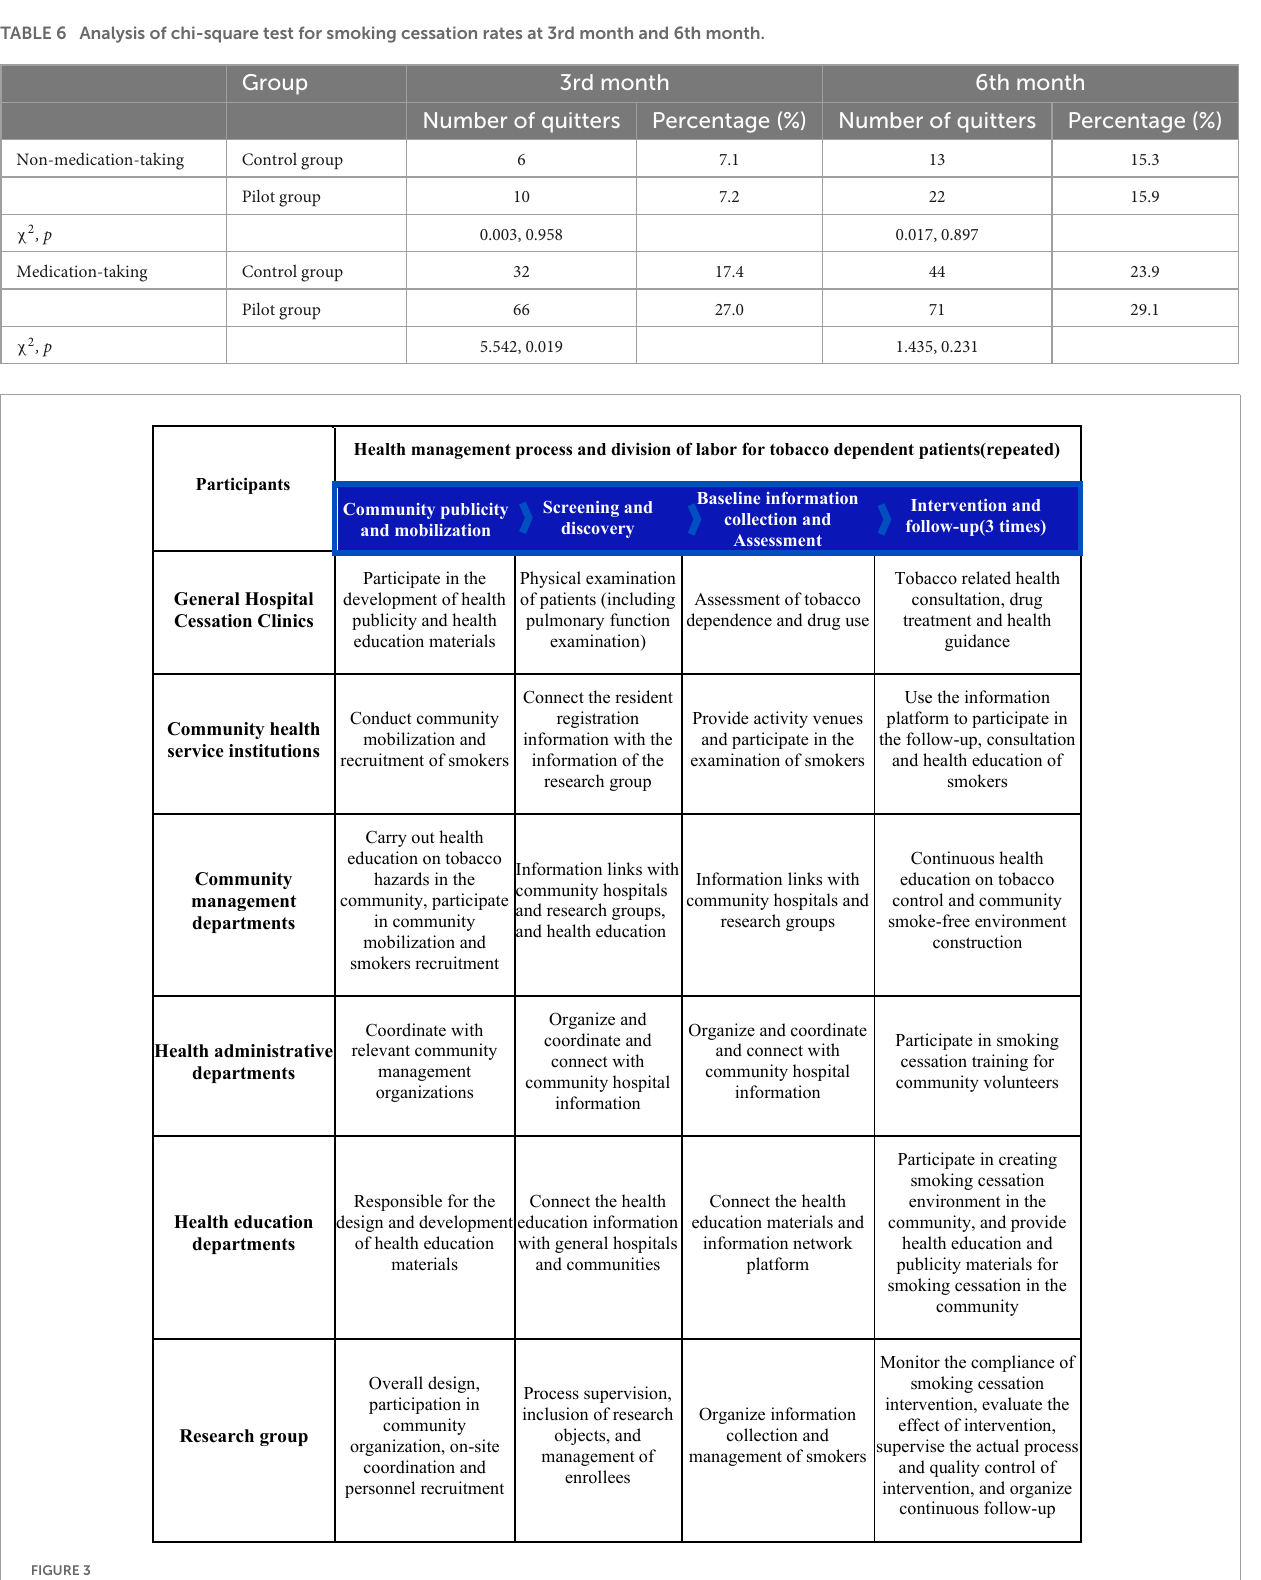
TABLE 6 Analysis of chi-square test for smoking cessation rates at 3rd month and 6th month.